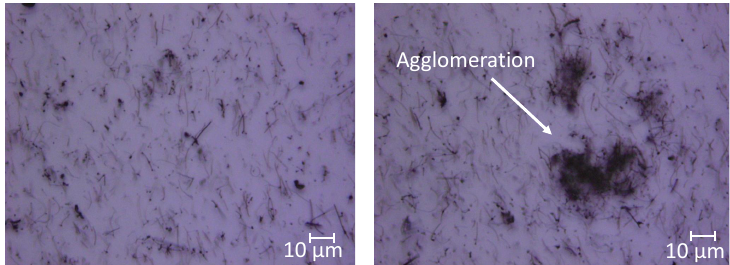
Figure 10. Optical transmission microscope images of 0.5 wt% MWCNT at two different magnifica- tions, showing individual ( left ) and agglomerated ( right ) CNTs.